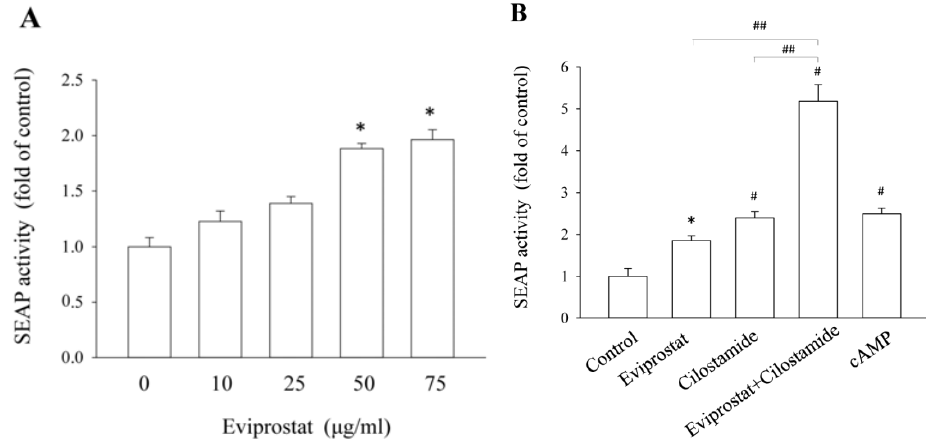
Eviprostat on phosphodiesterase 3 (PDE3) or 4 (PDE4) inhibitor-triggered activation